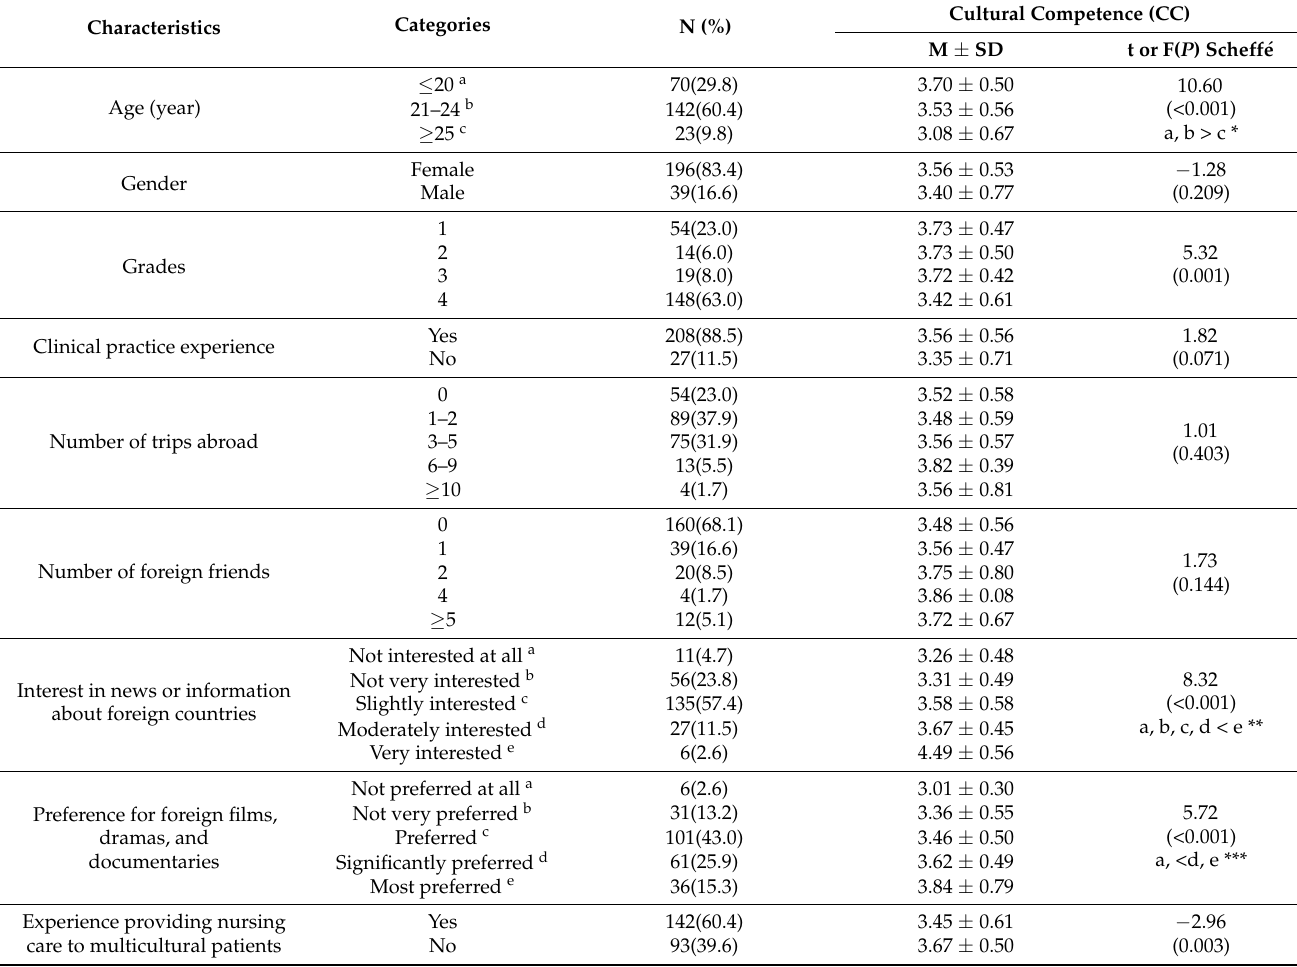
Table 1. General characteristics and differences in cultural competence (N =